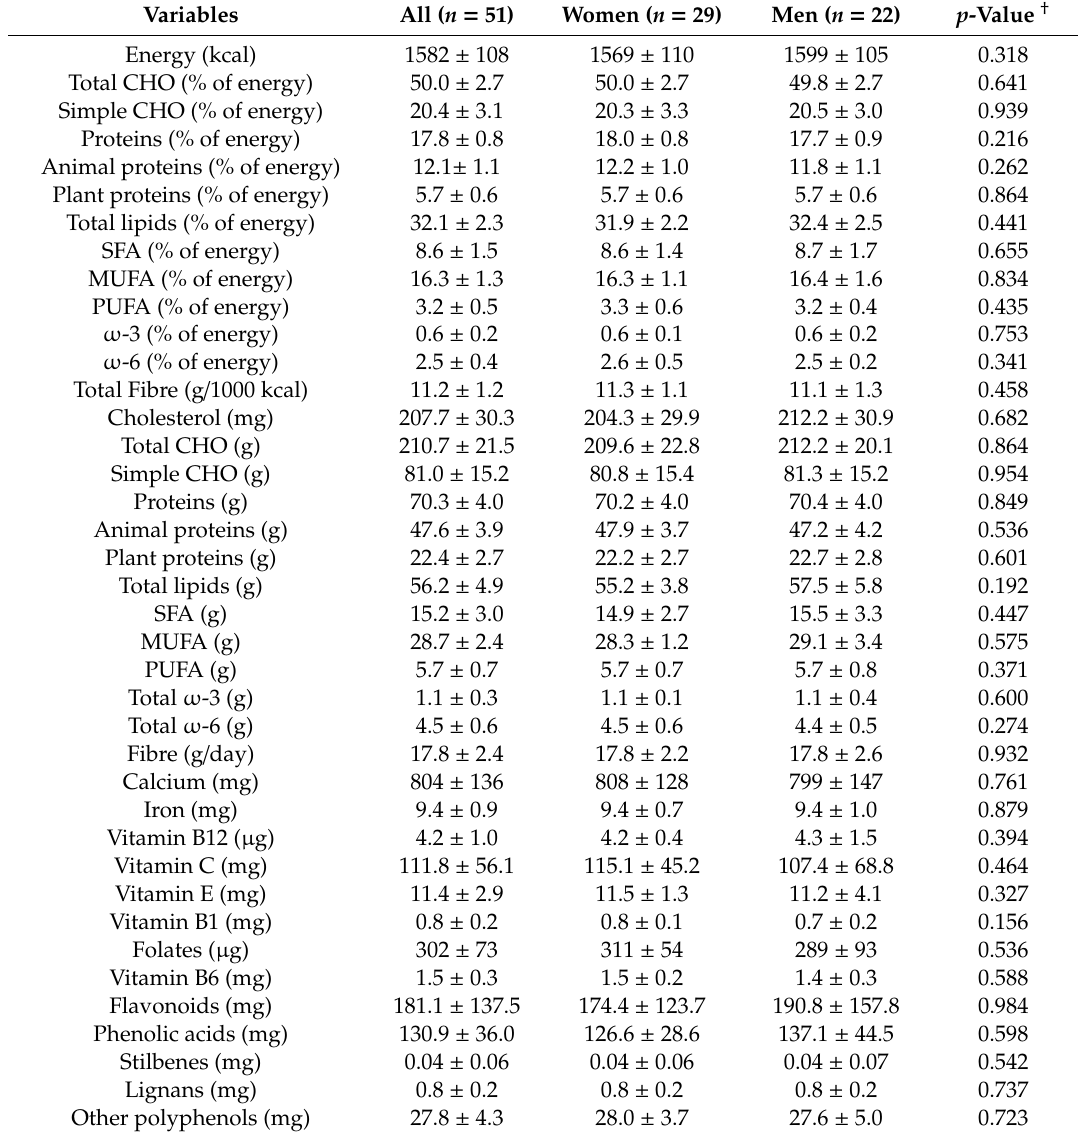
Table 3. Daily mean energy, nutrient and polyphenol intake at baseline in the whole group of subjects, in women and